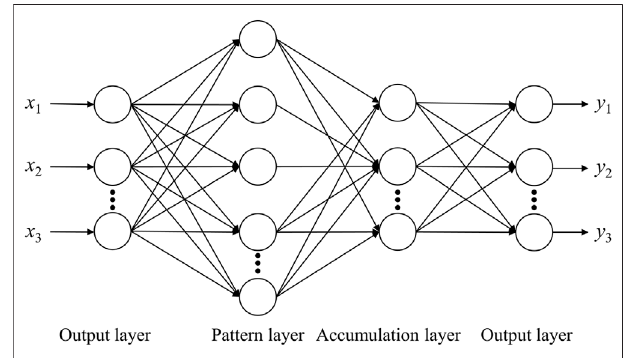
FIGURE 1 | The topology of probabilistic neural